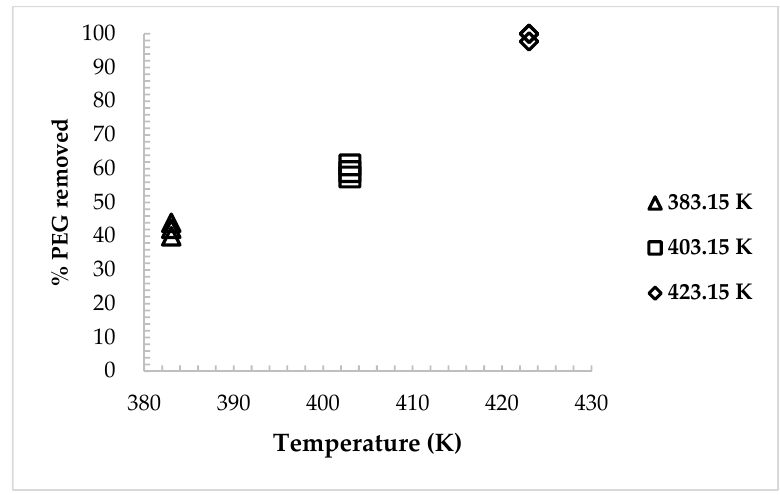
Figure 3. Removed weight fraction of polyethylene glycol (PEG) versus the temperature in cylindrical components after debinding by supercritical carbon dioxide (CO 2 ) under 40 MPa for four hours .